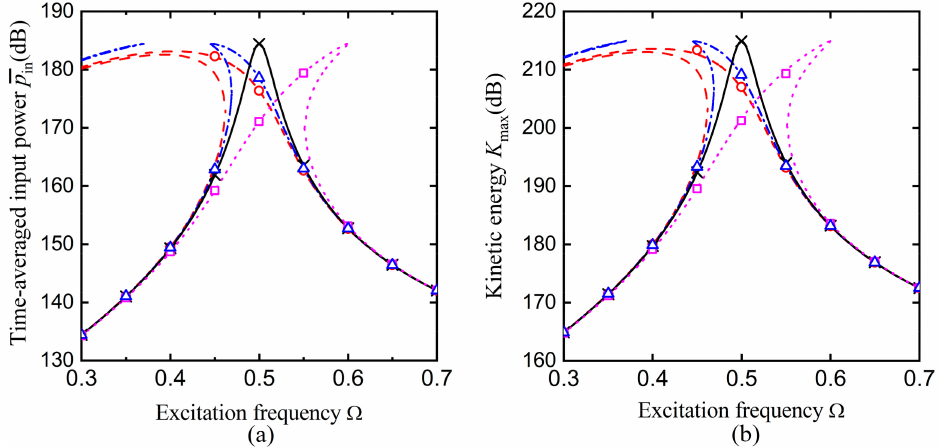
Figure 11. Effects of different combination of α and β with a fixed product on ( a ) the time–averaged input power and ( b ) the maximum kinetic energy. Dashed, solid line, dash–dot, and dotted lines for ( α , β ) = ( − 1.5, 0.5 ) , ( − 1.25, 0.6 ) , ( − 1, 0.75 ) , and ( − 0.5, 1.5 ) , respectively. Circles, triangles, crosses, and squares denote the corresponding numerical results.